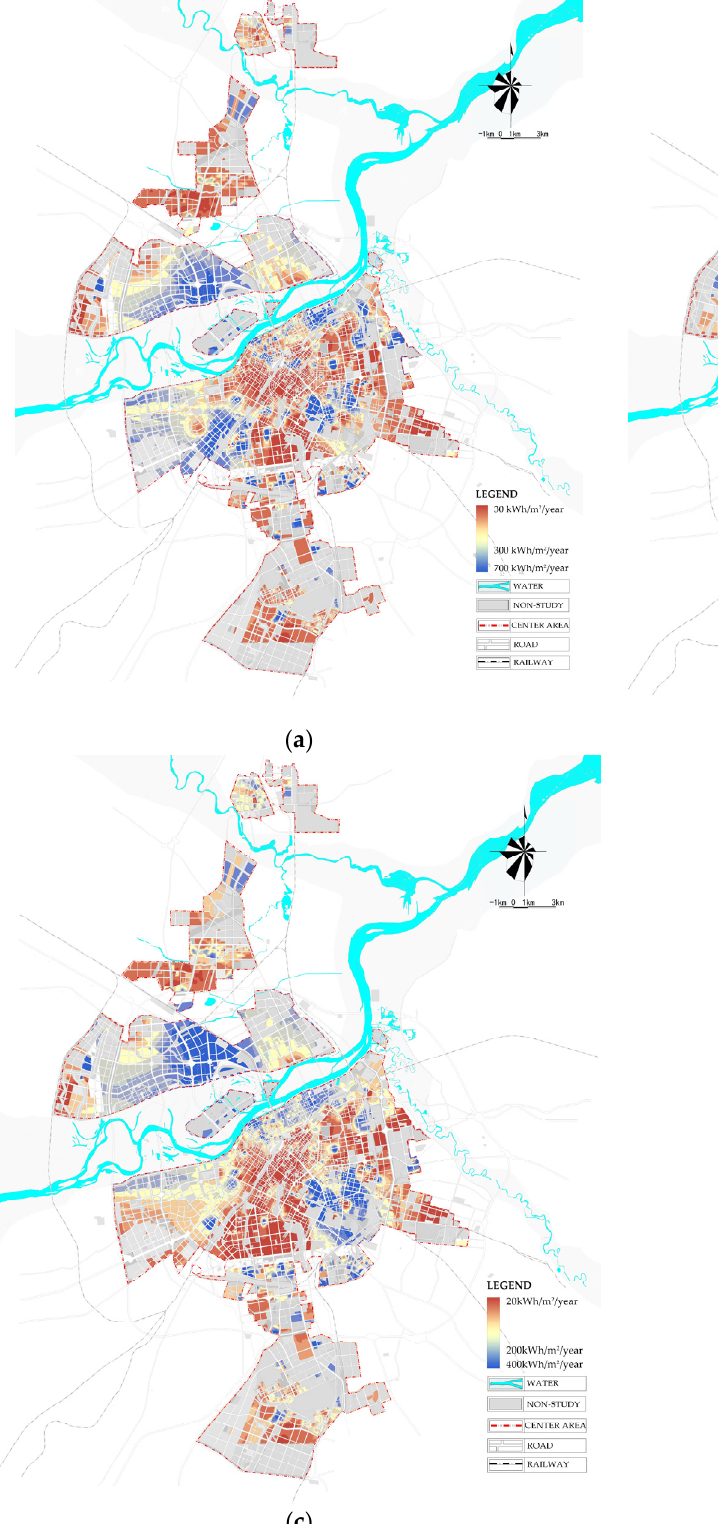
Figure 11. EUI of the central urban area under the baseline scenario. ( a ) Total EUI; ( b ) electricity EUI; ( c ) heating EUI. The spatial distribution of the electricity and heating EUIs is similar but different. The difference mainly lies in the distribution of high-EUI areas. The high EUI of electricity